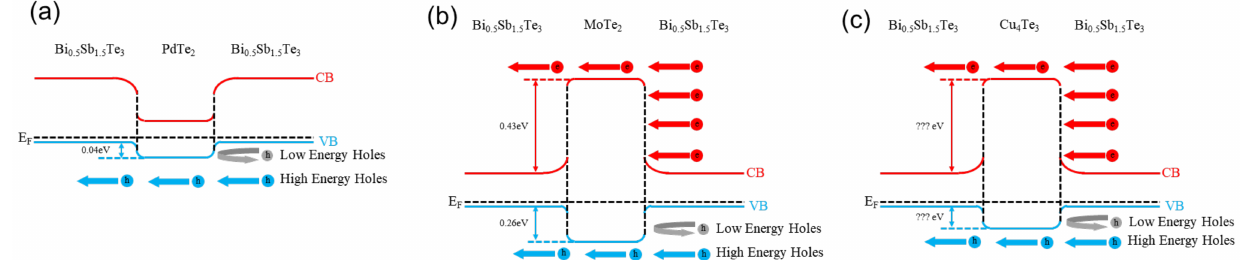
Figure 3. Band alignments in a Bi 0.5 Sb 1.5 Te 3 – M heterojunction ( M = semiconductor).